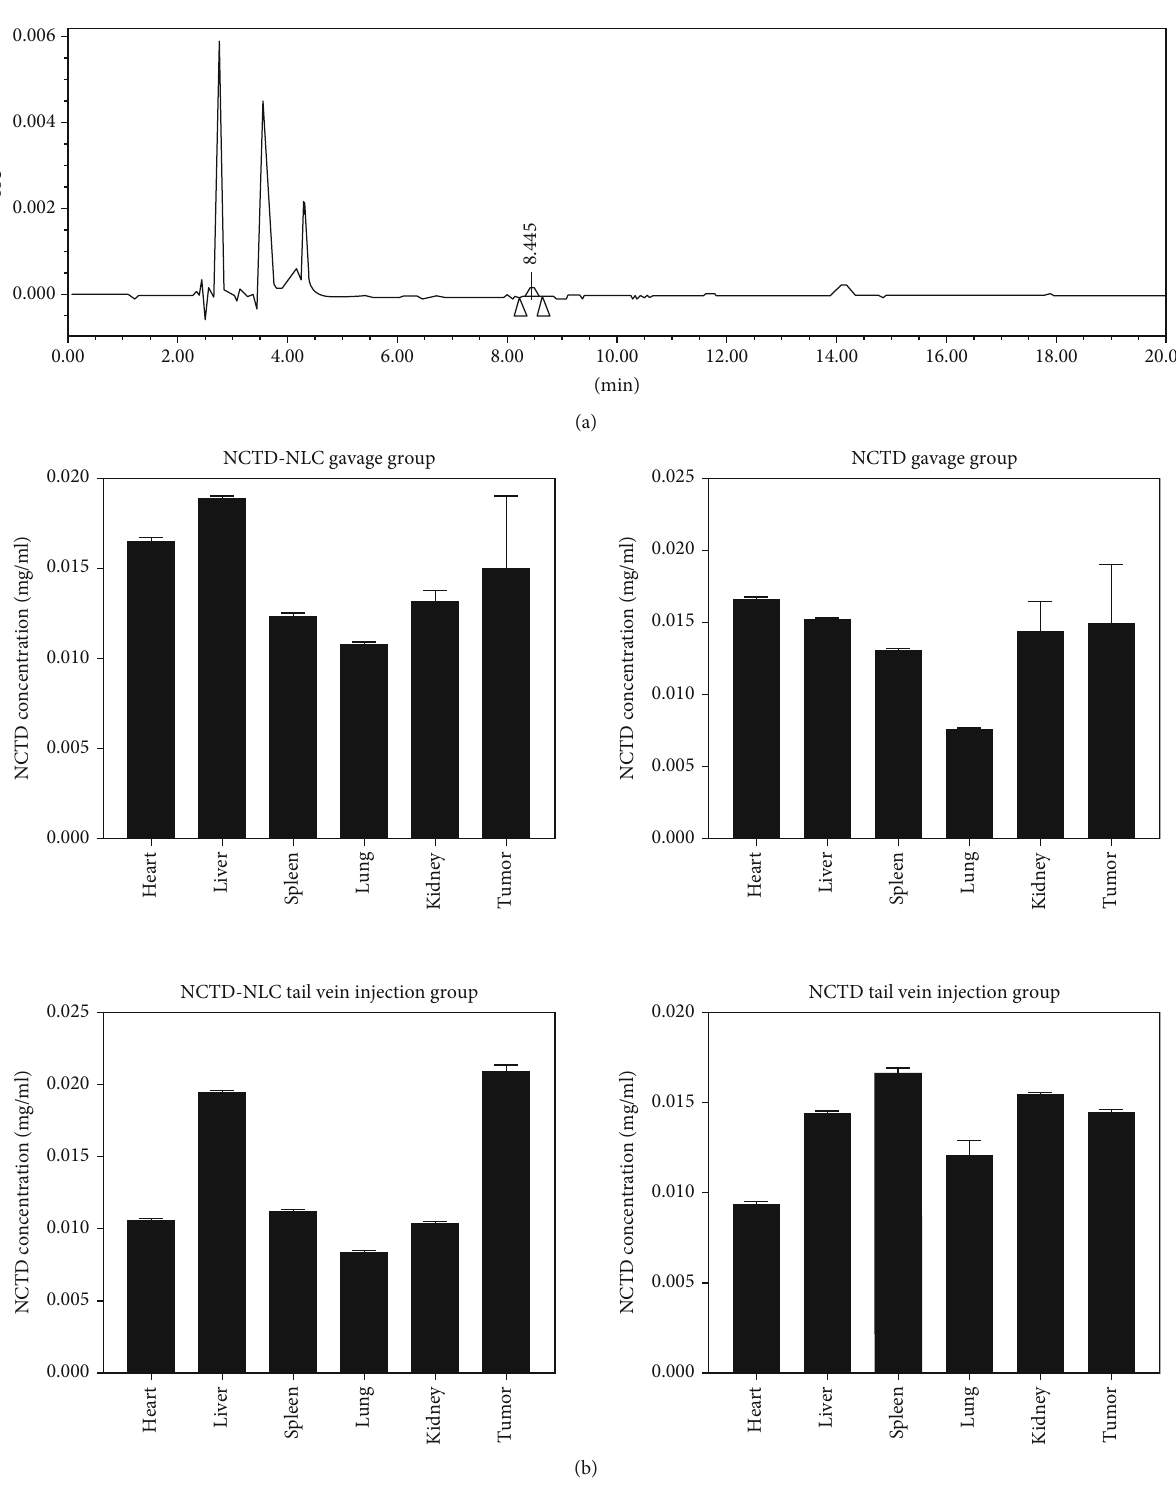
Figure 5: Detection of NCTD content in tumors by HPLC: (a) HPLC pro fi les of NCTD; (b) statistical results of NCTD (gavage) NCTD-NLC. The remaining 4 were used as exper- each group): tumor-bearing nude mice were injected with imental death supplements. The hepatoma cells were subcu- NCTD through tail vein, tumor-bearing nude mice were taneously inoculated in the right armpit of nude mice at injected with NCTD-NLC through tail vein, tumor-bearing 1 × 10 7 cells per mouse. After tumor inoculation in nude nude mice (gavage) NCTD, and tumor-bearing nude mice